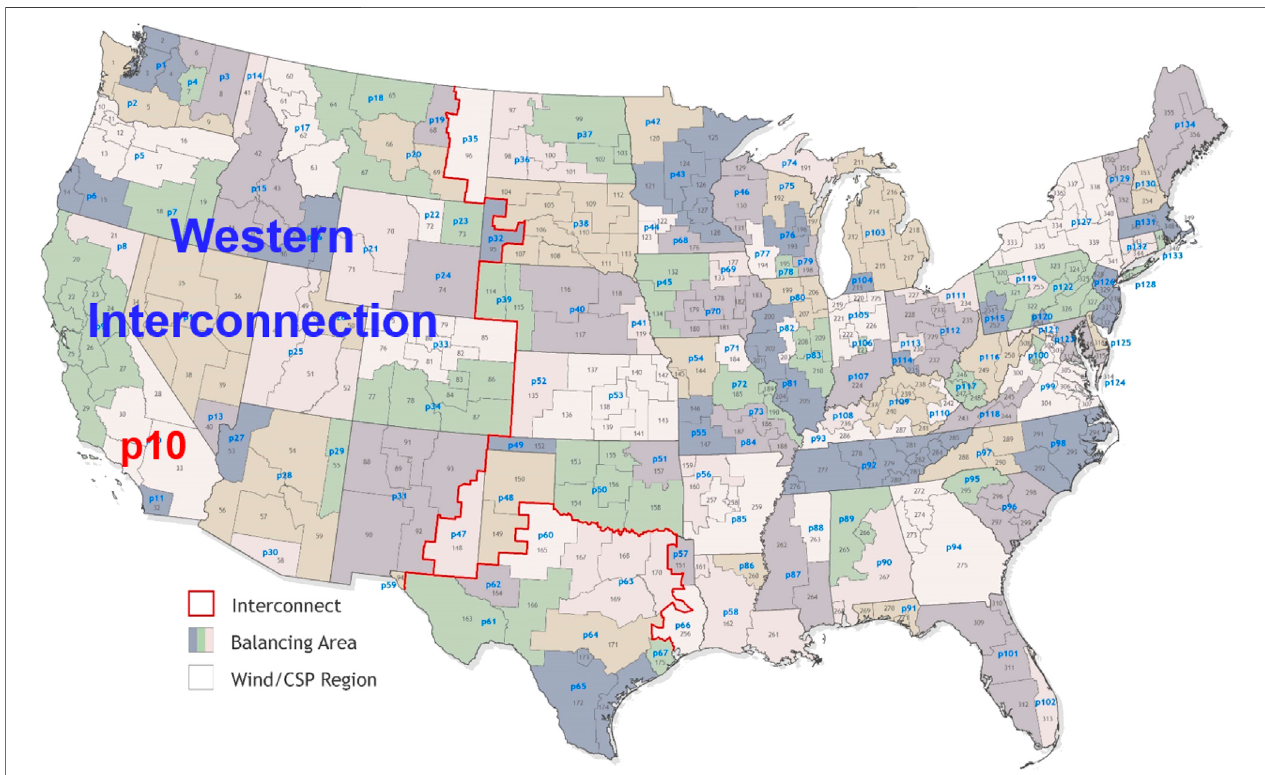
FIGURE 1 | Map of regional Energy deployment system structure of the